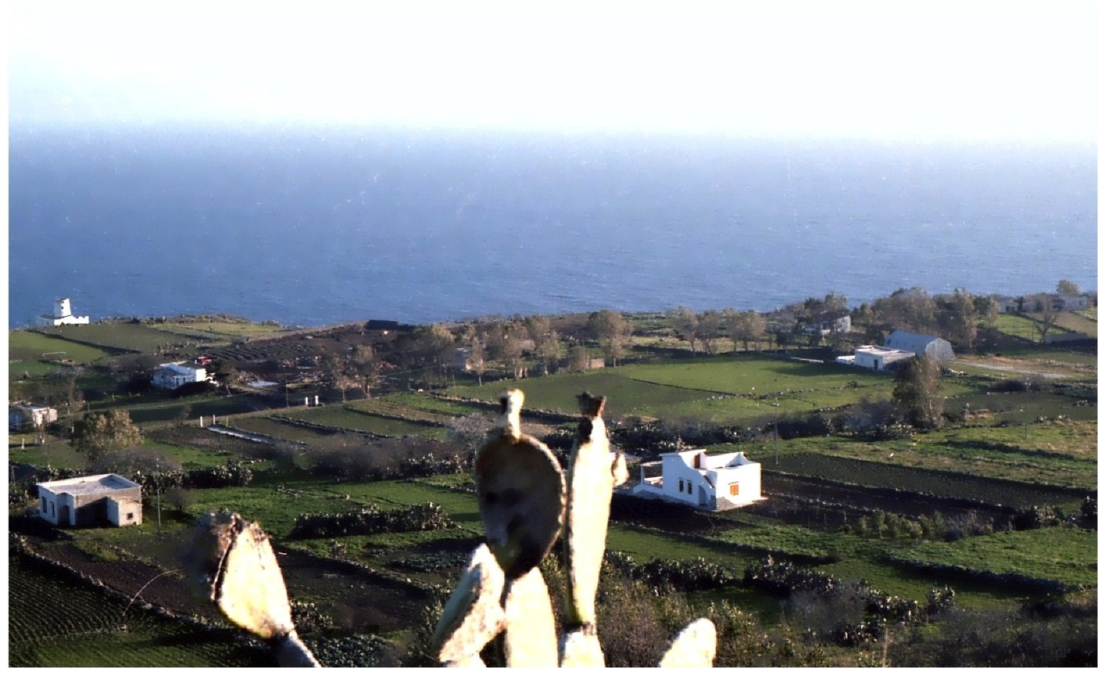
Figure 5: The countryside of Piano dei Cardoni, on the southern side of the island of Ustica, was the site of settlements of the Late Neolithic and Copper Age (courtesy of Giacomo